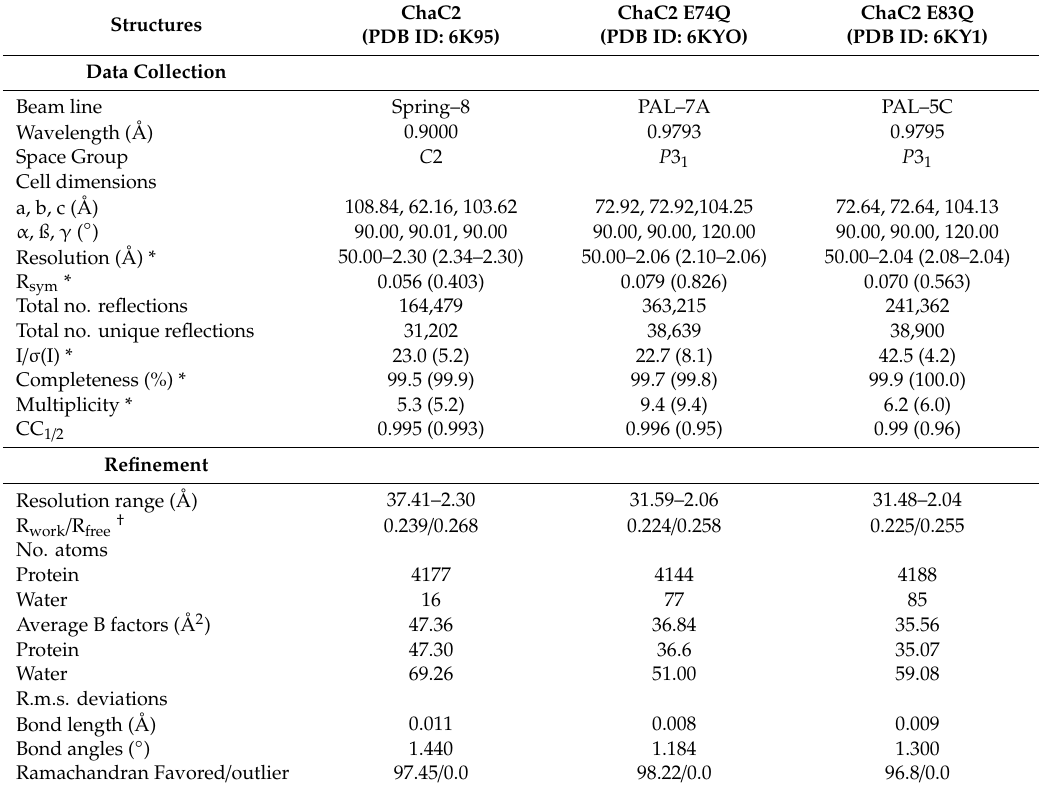
Table 2. Data collection and refinement statistics of ChaC2